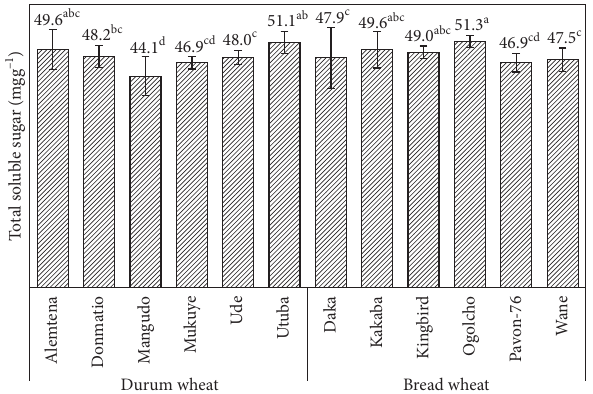
Figure 6: Means for the main effects of variety and water stress on the total soluble sugar content of durum and bread wheat in Kulumsa.